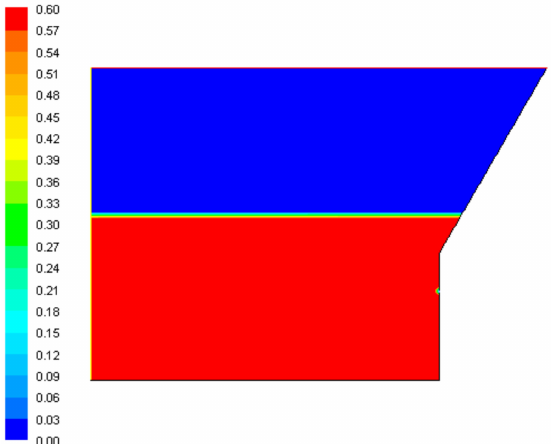
Figure 2. Initialization condition of the coke volume fraction in the